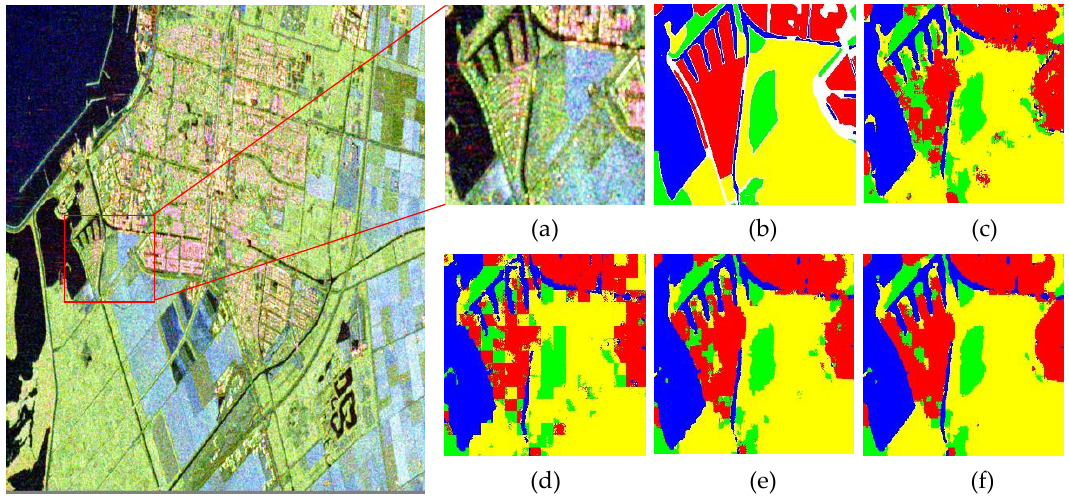
Figure 12. Classification result of local area of RS-2 Flevoland. ( a ) Pauli RGB image; ( b ) Ground truth map; ( c ) Lenet-5; ( d ) FFS-CNN, no overlap; ( e ) FFS-CNN, 1/2 overlap; ( f ) FFS-CNN, 3/4